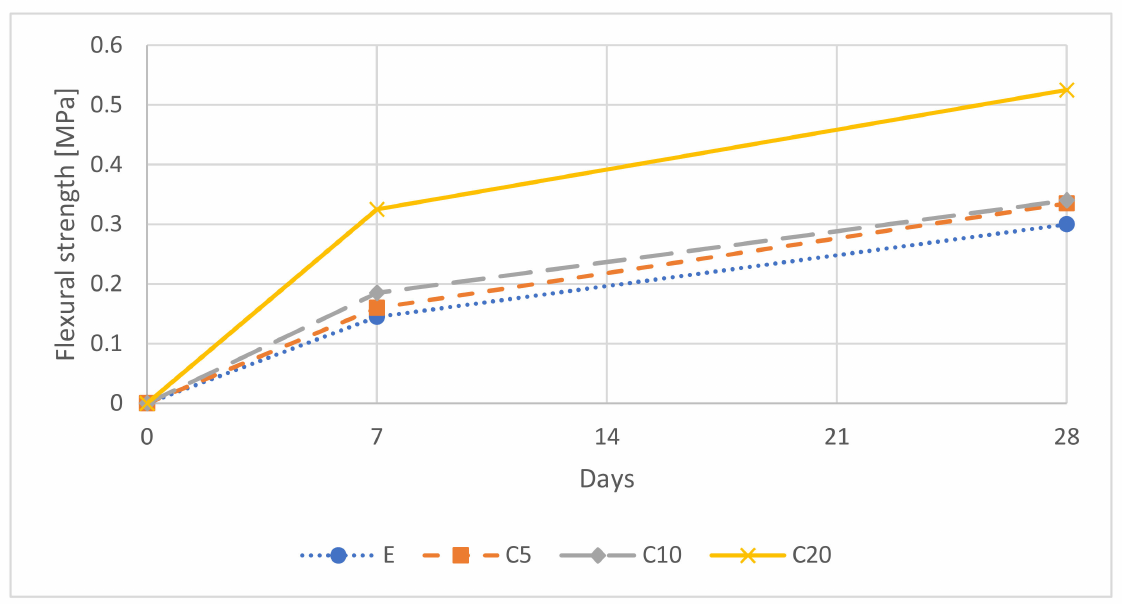
Figure 5. Development of flexural strength from 7–28 days in Series 1 (same w/b ratio, different percentage of